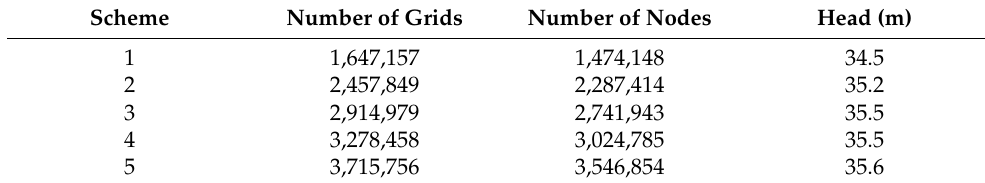
Table 2. Scheme of mesh-dependence test.